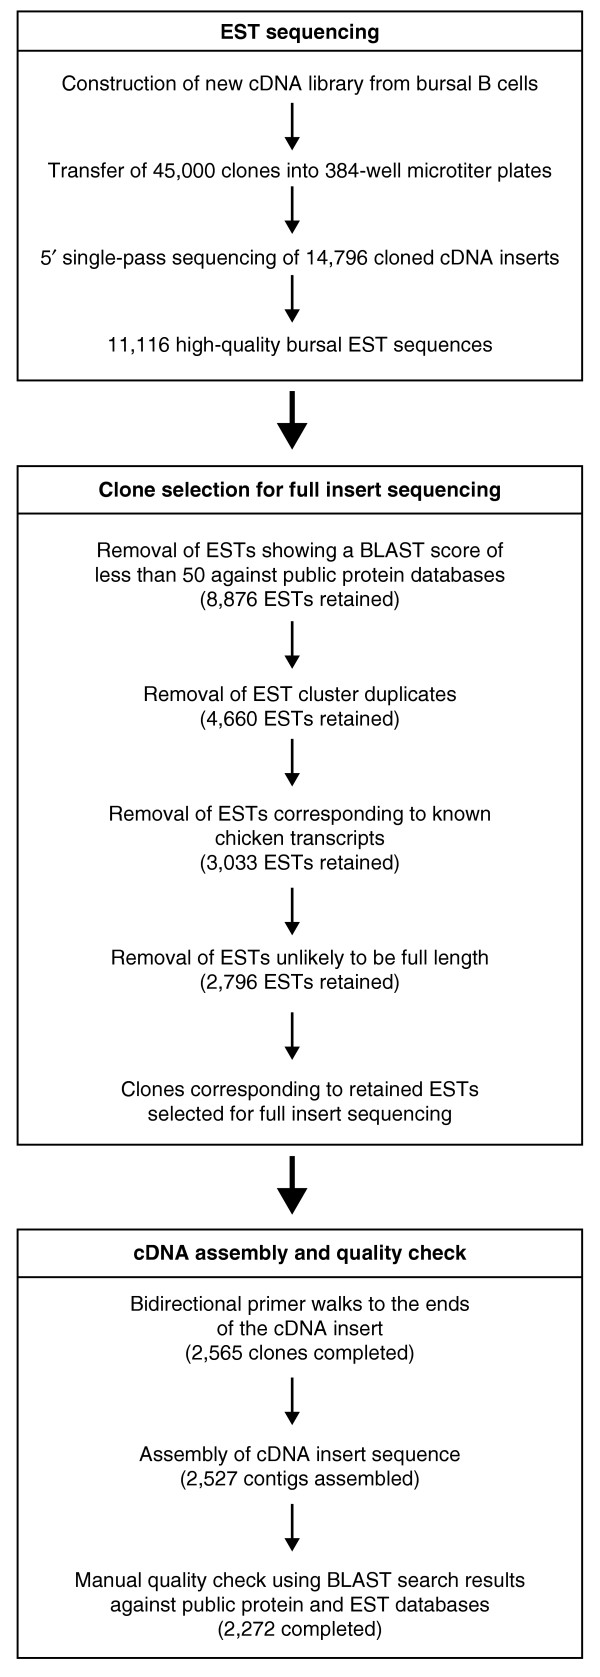
Outline of full-length bursal cDNA production.